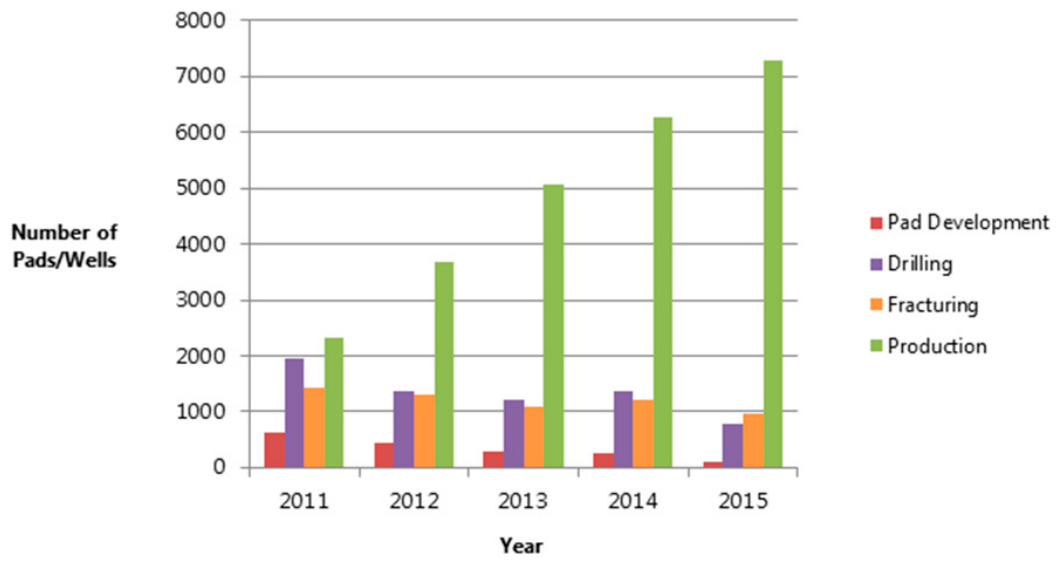
Figure 5. Number of unconventional gas wells in Pennsylvania by phase of development, 2011–2015.